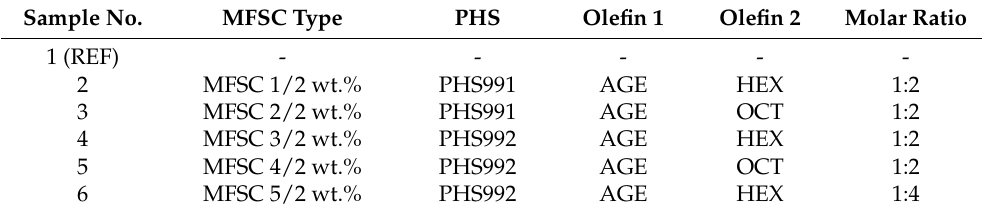
Table 1. Compositions of the prepared epoxy gelcoat samples and their modifiers. Sample